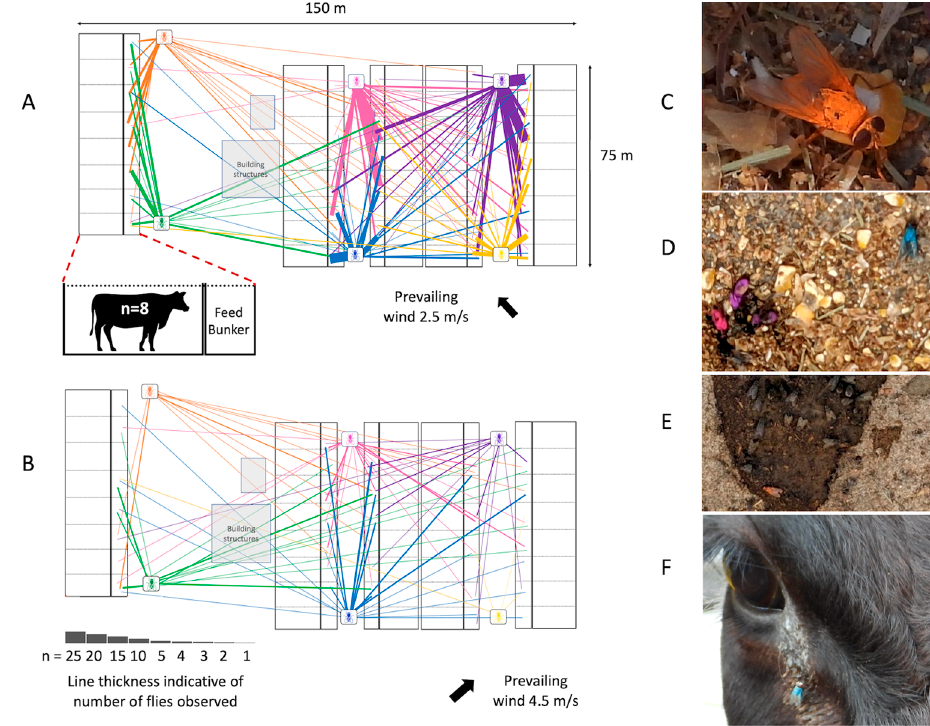
Figure 2. House fly movement within a concentrated animal feeding operation. Location of colored flies observed 1 h ( A ) and 24 h ( B ) after release. Flies were predominantly observed in feed bunkers containing animal feed ( C , D ) though also on manure ( E ) and animals ( F ). Photos by Cassandra Olds.